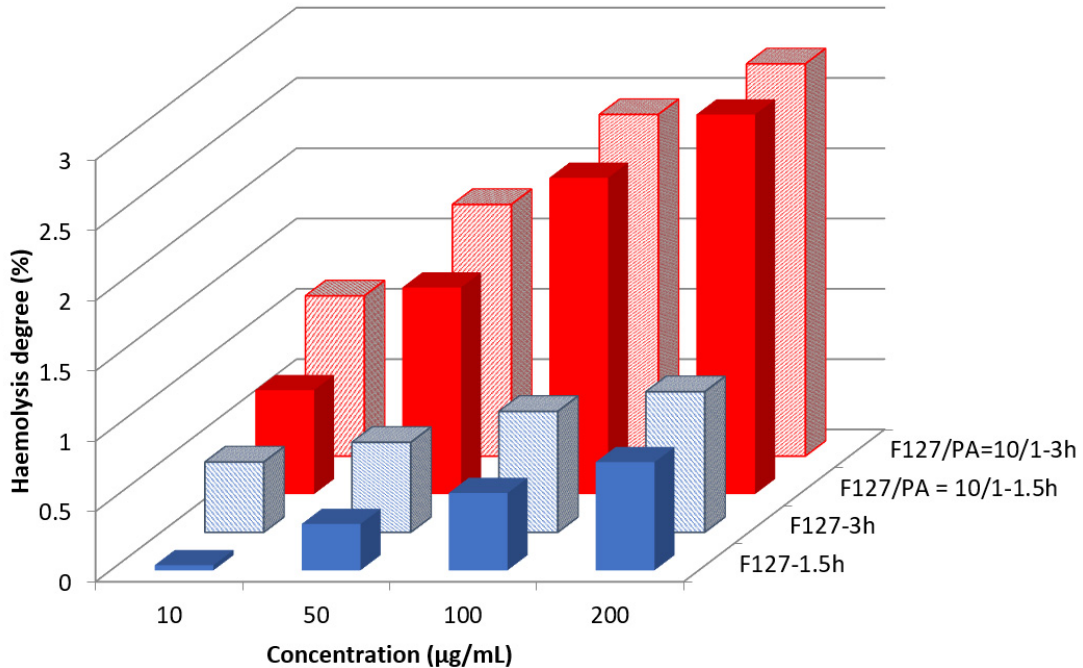
Figure 5. Evolution of the hemolysis degree for free F127 micelles and F127/API = 10/1 sample as a function of concentration and